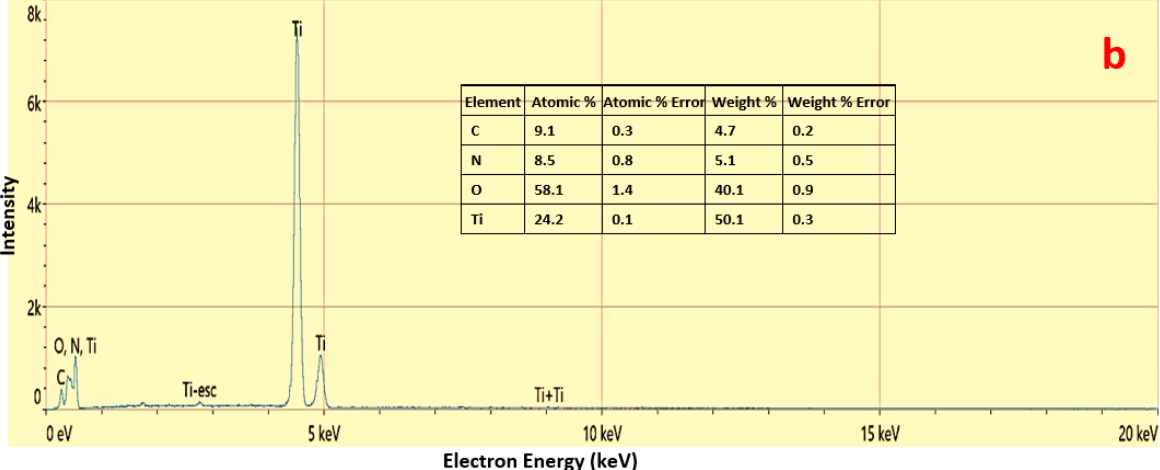
Figure 1. The EDS spectra showing the composition of ( a ) net TiO 2 and ( b ) 5.0 wt% N-TiO 2 .